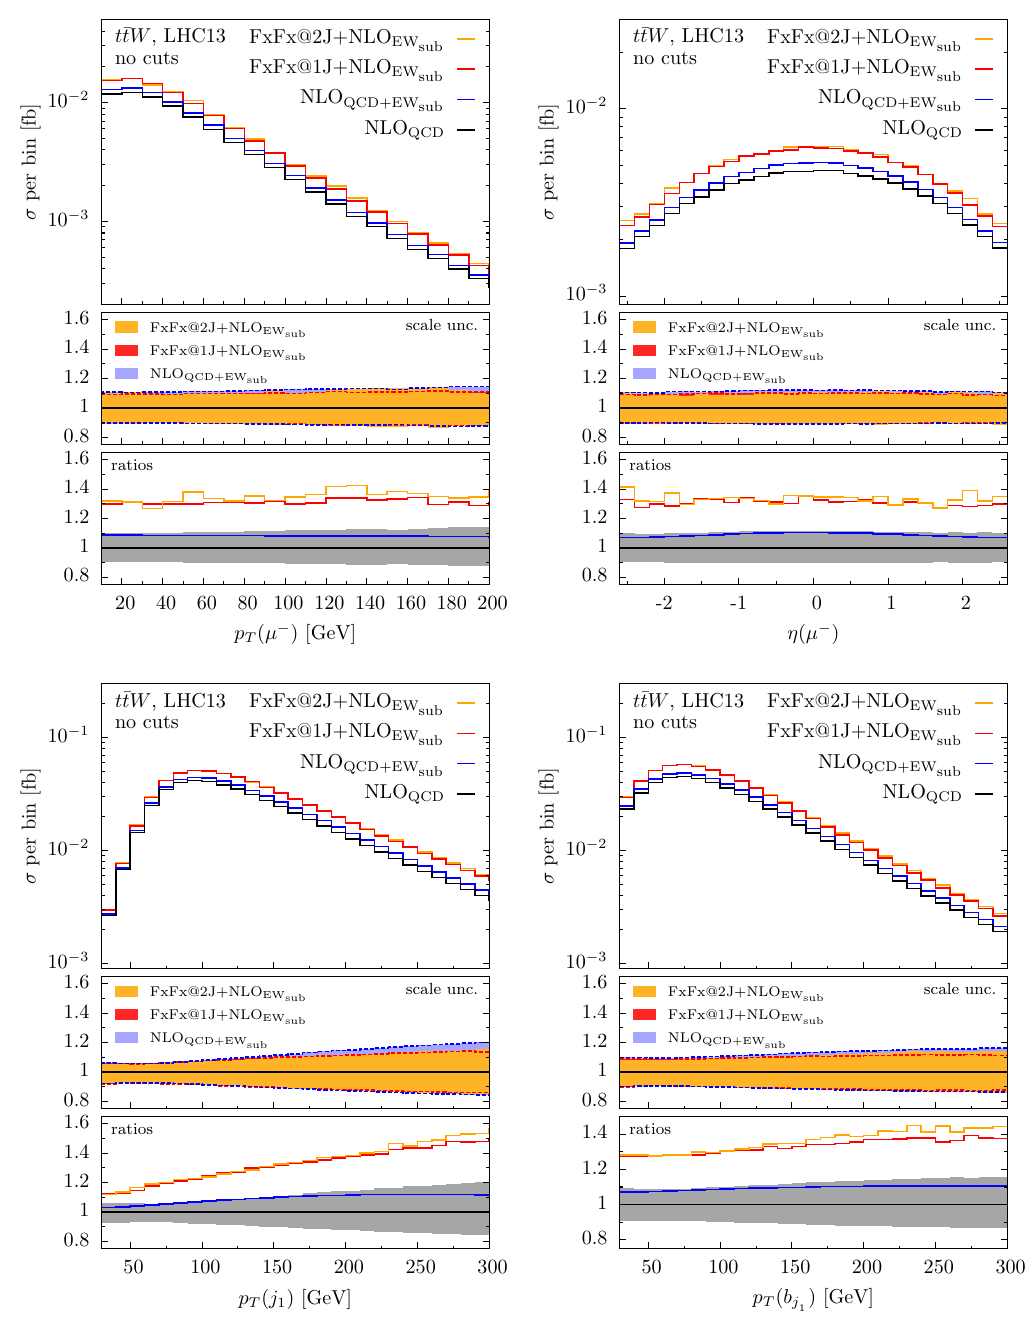
Figure 6 . Differential distributions at the inclusive decay level for the t ¯ tW